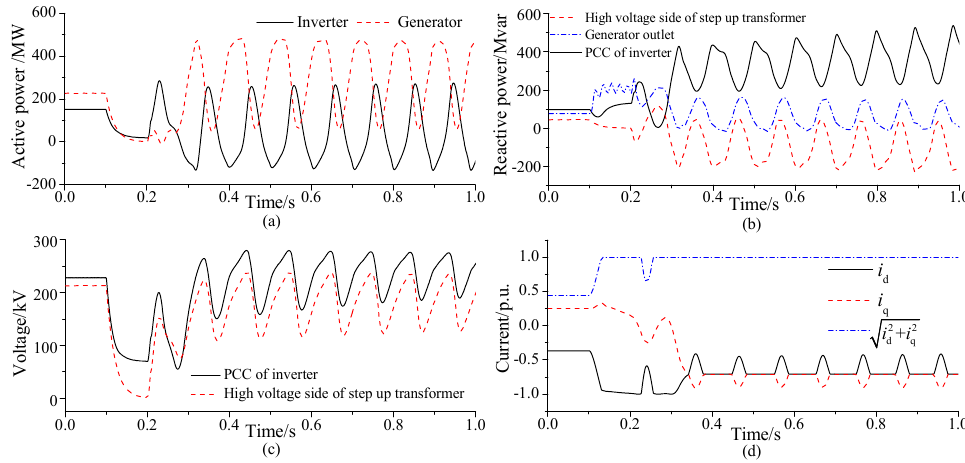
Figure 8. The behaviour under PLL phase locking failure: ( a ) active power of inverter and generator, ( b ) reactive power of inverter and generator, ( c ) voltage of inverter and load, and ( d ) AC current of inverter.